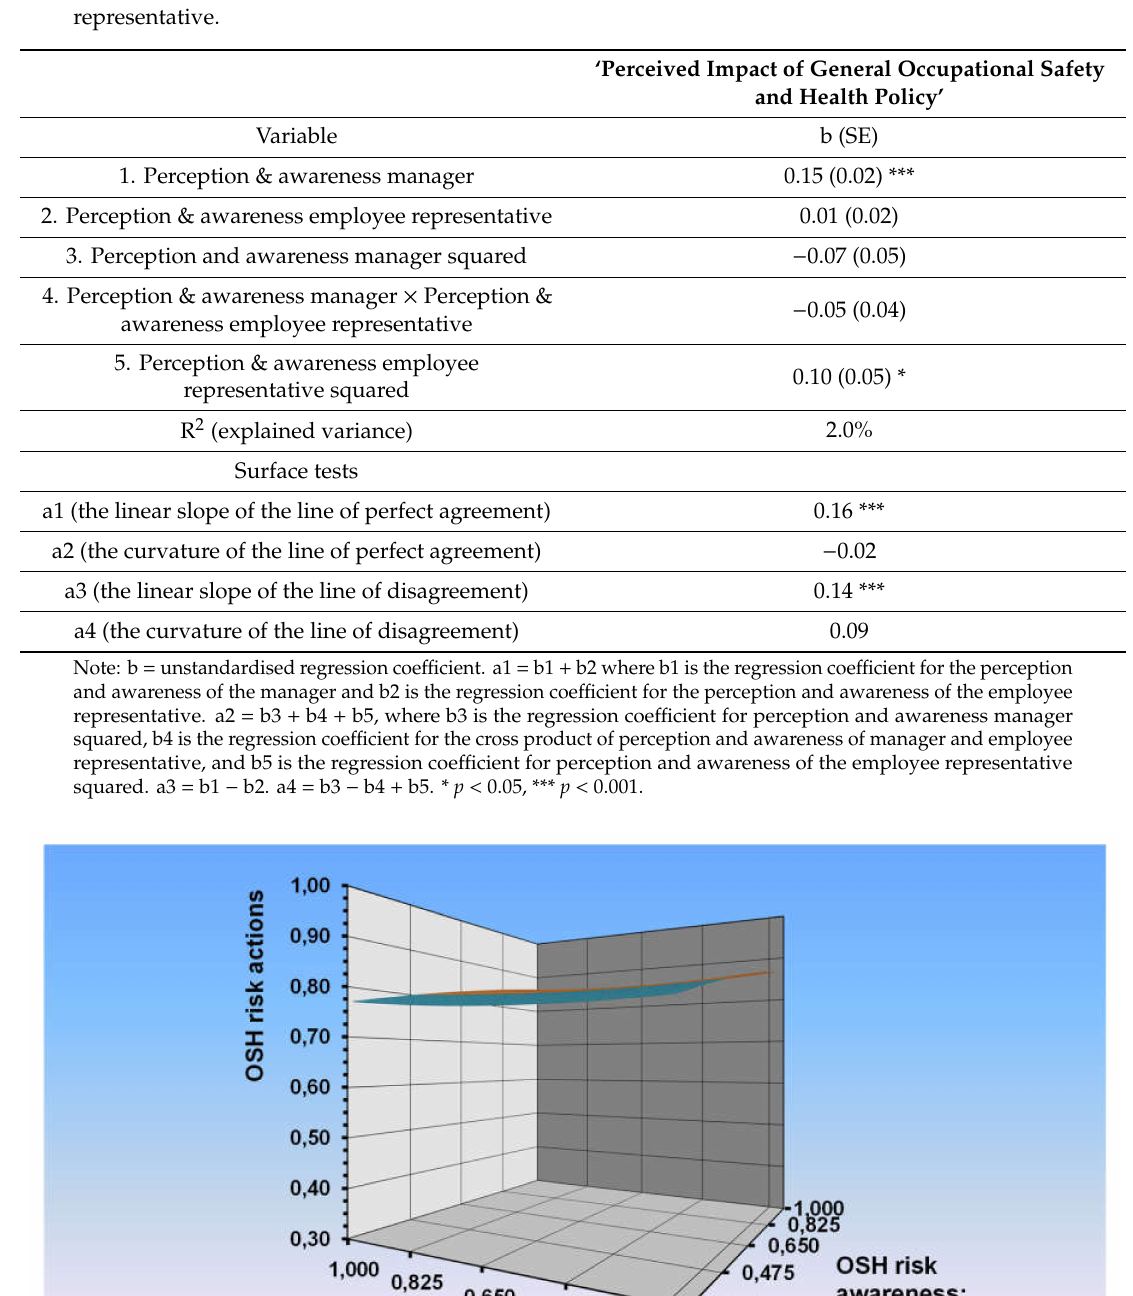
Table 5. Response surface tests for OSH perception and awareness of the manager and the employee representative.